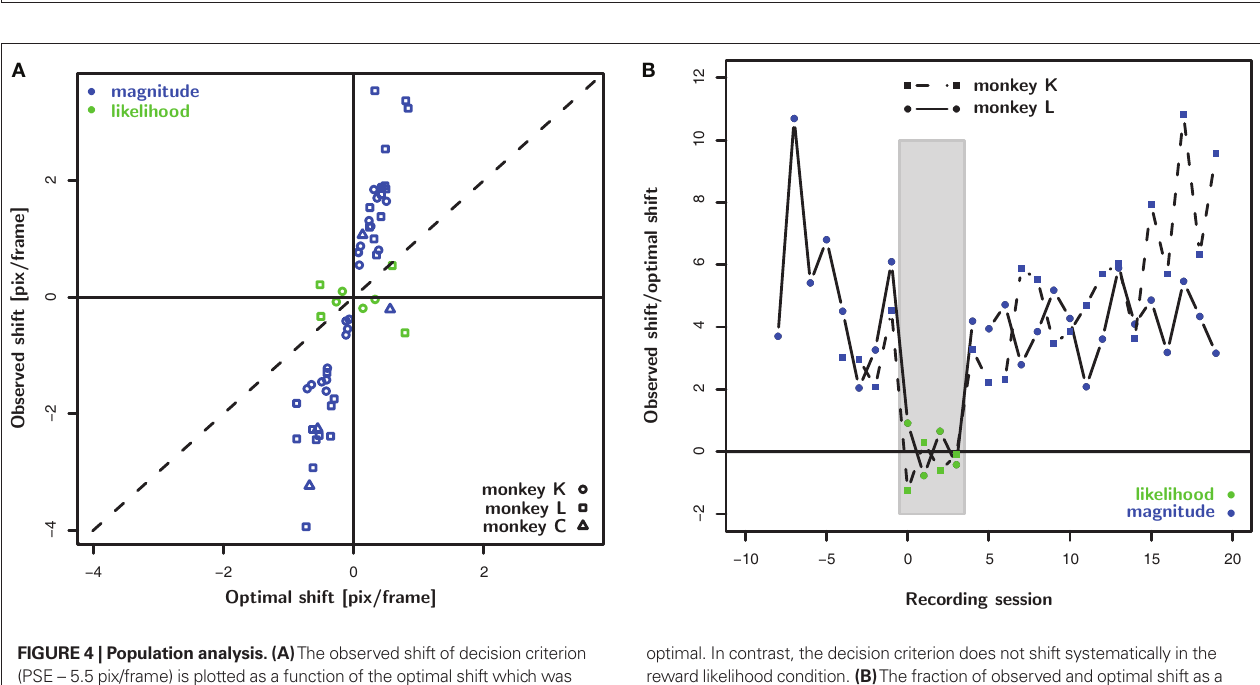
Figure 4 | Population analysis. (A) The observed shift of decision criterion (PSE – 5.5 pix/frame) is plotted as a function of the optimal shift which was calculated based on the stimulus discriminability observed the same day in the biased condition. The green and blue color corresponds to the reward magnitude and reward likelihood conditions, respectively. In the reward magnitude condition, the animals consistently shift their decision criterion farther than